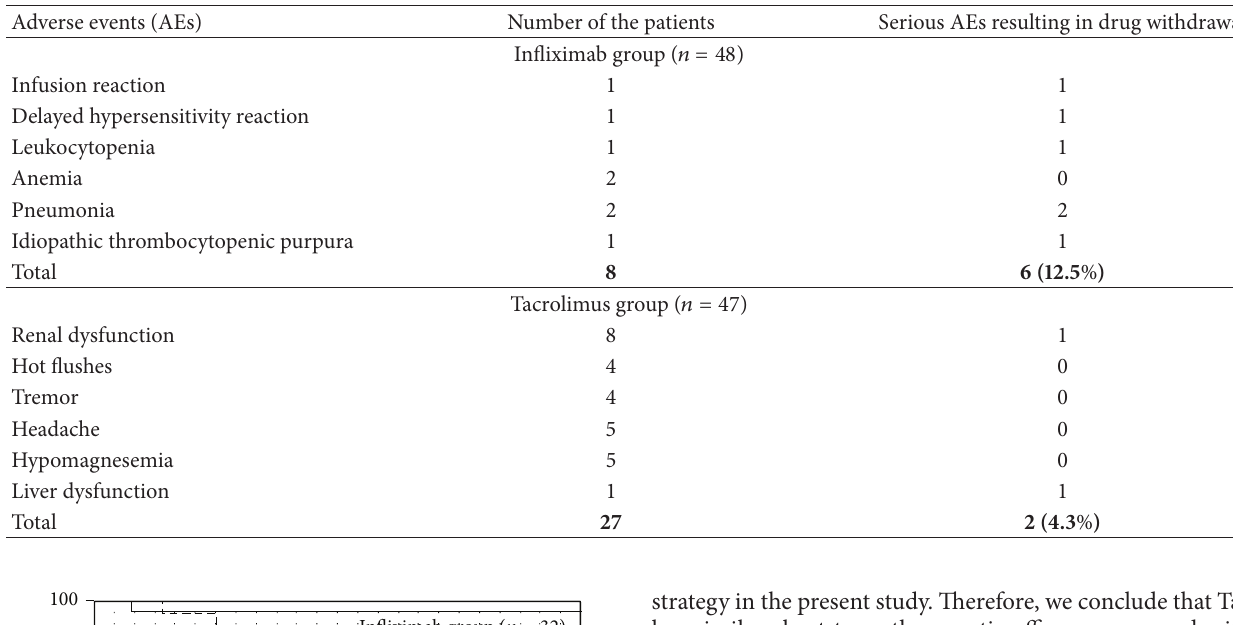
Table 4: Adverse events during the treatments.